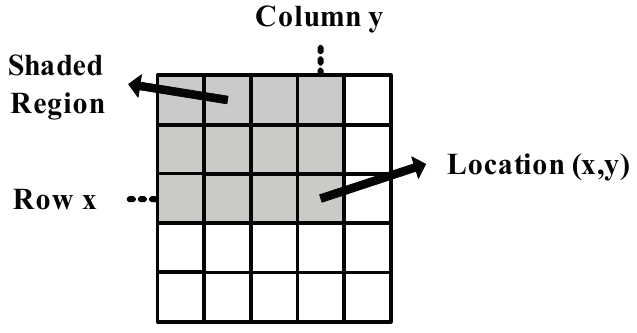
Figure 1. Calculation of integral image value at image location ((cid:1876), (cid:1877)) . The shaded region indicates all pixels to be summed.